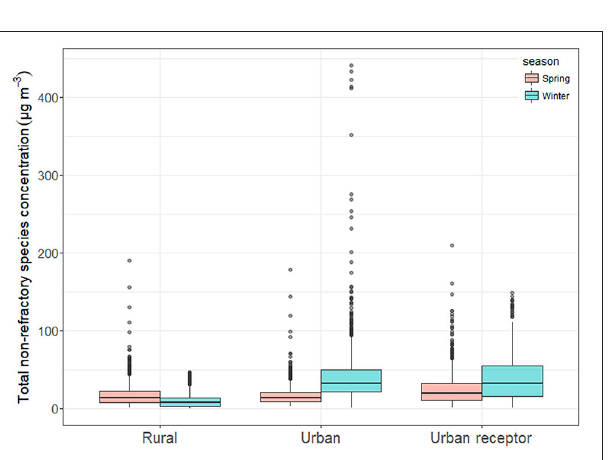
FIGURE 5 | Average concentrations ( µ g m − 3 ) of total non-refractory species during winter and spring campaigns. The black line at the middle of box represents the average value in each season. The circles represent 1-h concentrations outside the 95% confidence intervals in the mean.